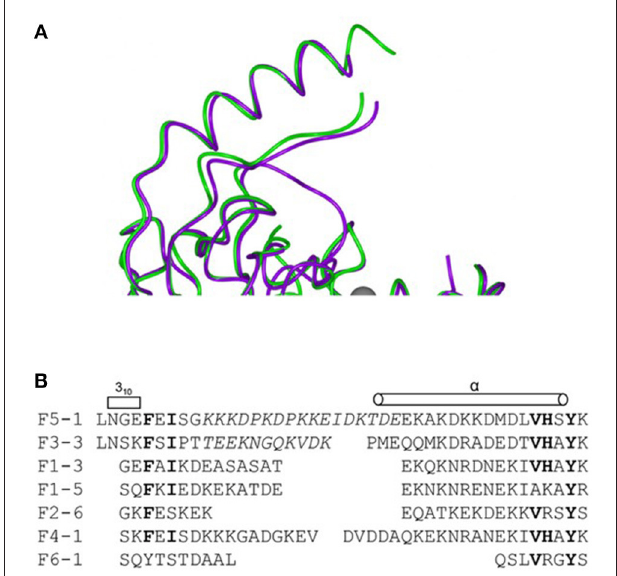
FIGURE 1 | Combining sequence data with and structural information to define variation in a meningococcal antigen. The structure and alignment of the FrpB (FetA) hypervariable sequence regions. (A) Superposition of two hypervariable regions F5-1 purple, F3-3 (A chain) green. (B) Sequence alignment of the HR regions from the major FrpB variants. Reproduced without modification from Saleem et al. ( 20) under CC